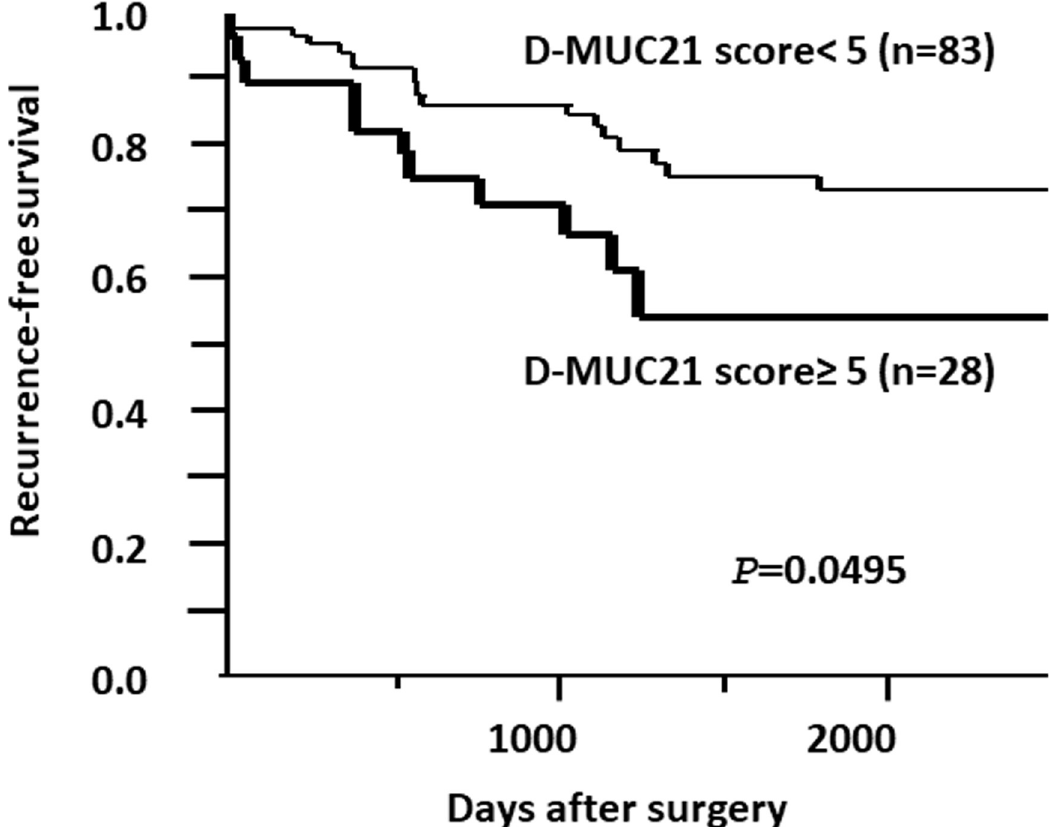
Fig 6. Kaplan-Meier recurrence-free survival ( RFS ) curves for the association between the level of MUC21D and disease recurrence. The RFS was significantly worse in MUC21D high expressors. A P -value was calculated using the log-rank test. n, number of tumors examined. A total of 111 patients with EGFR -mutated lung adenocarcinomas were examined with a median follow-up period of 52 months (range: 4–155 months).